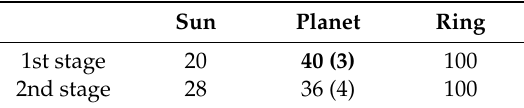
Table 1. Gear parameters of the fixed gearbox.